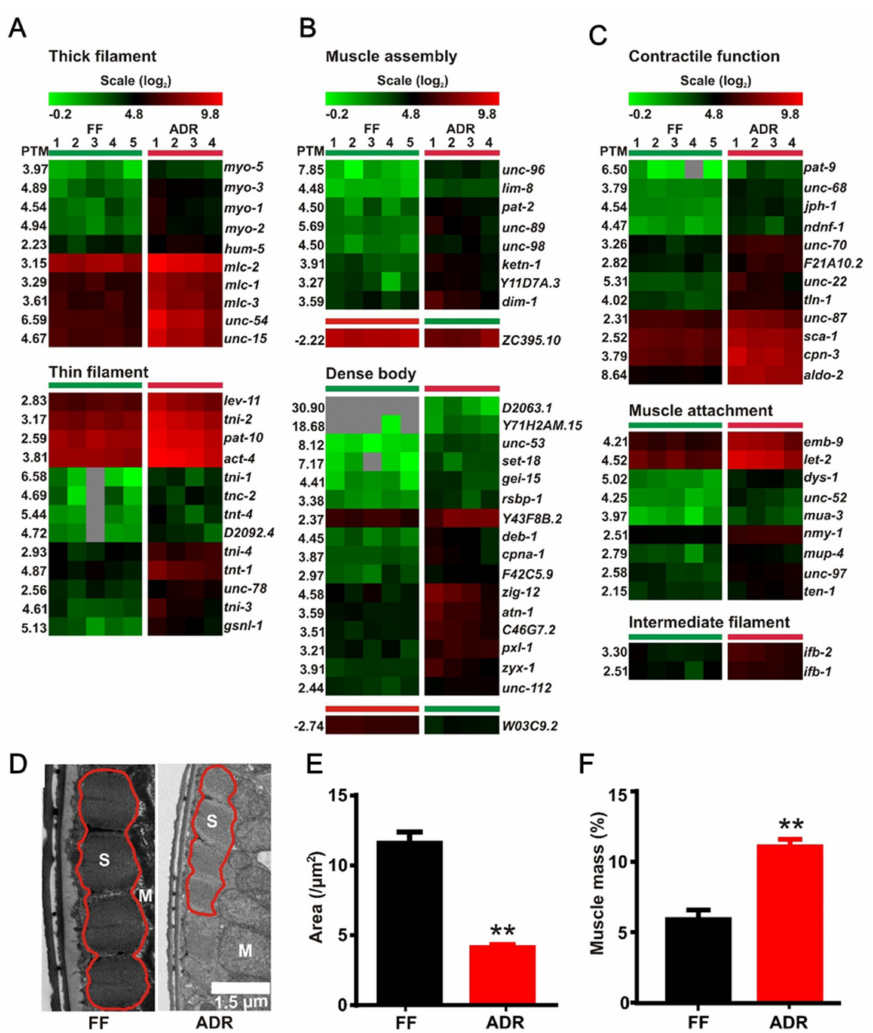
Figure 6. DEGs involved in muscle structure and function. ( A – C ) Up-regulated genes of thick filaments, thin filaments, muscle assembly, dense body, and muscle function. ( D ) Transmission electron micrographs (TEM) of muscle structure of both fully fed (FF) and axenically dietary restricted (ADR) worms; S: sarcomere, M: mitochondrion. Sarcomere size ( E ) and relative muscle mass ( F ) in FF and ADR worms, **: p <